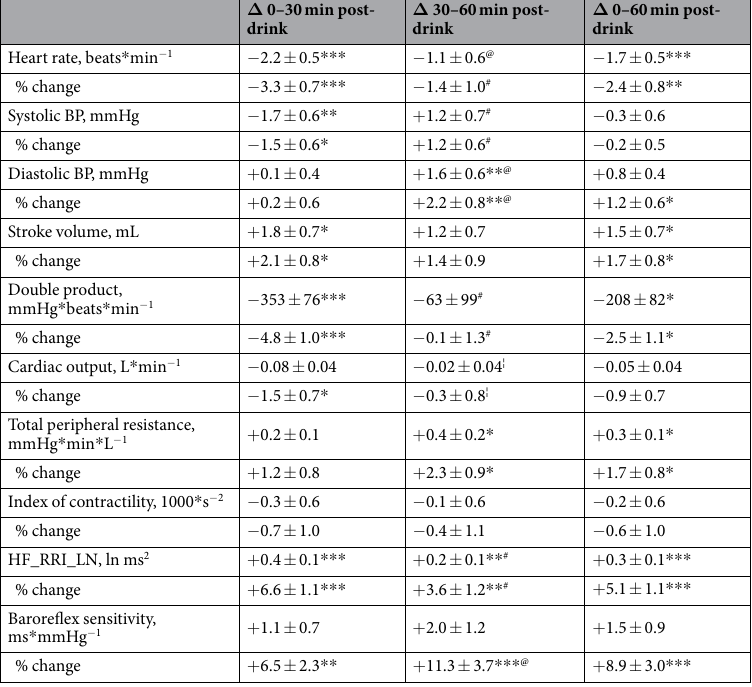
+ 1.2 ± 0.8 + 2.3 ± 0.9 * + 1.7 ± 0.8 * Index of contractility, 1000 * s − 2 − 0.3 ± 0.6